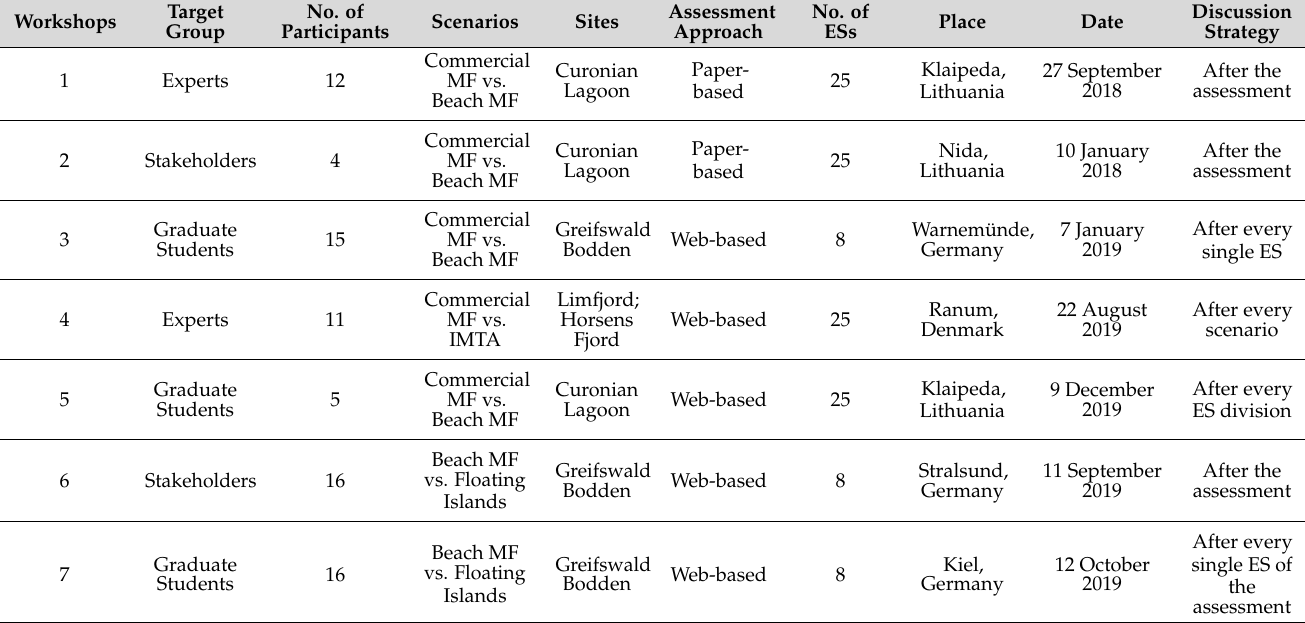
Table 2. Overview of Ecosystem service assessment workshops and applied scenarios and